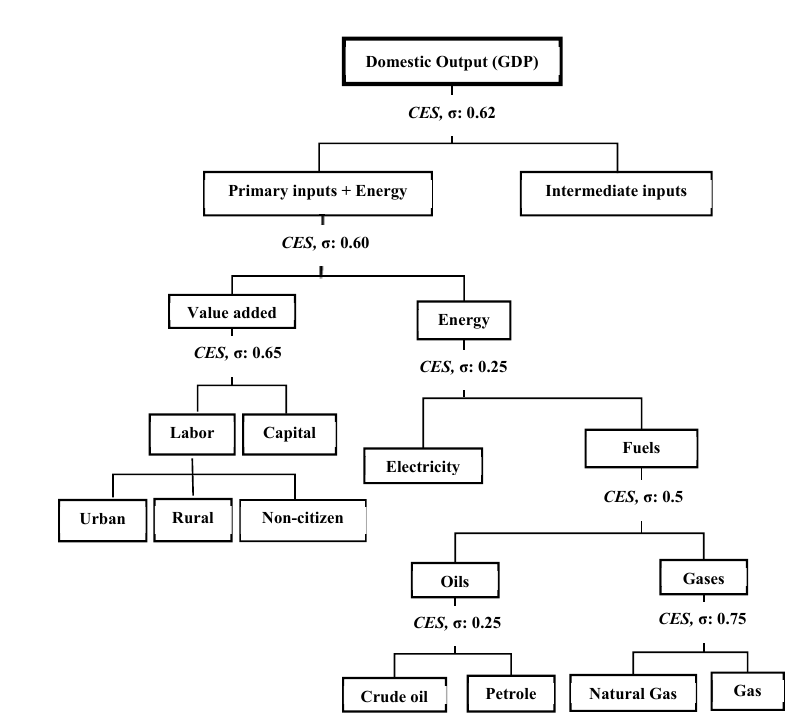
Fig. 4: The structure of Malaysia computable general equilibrium